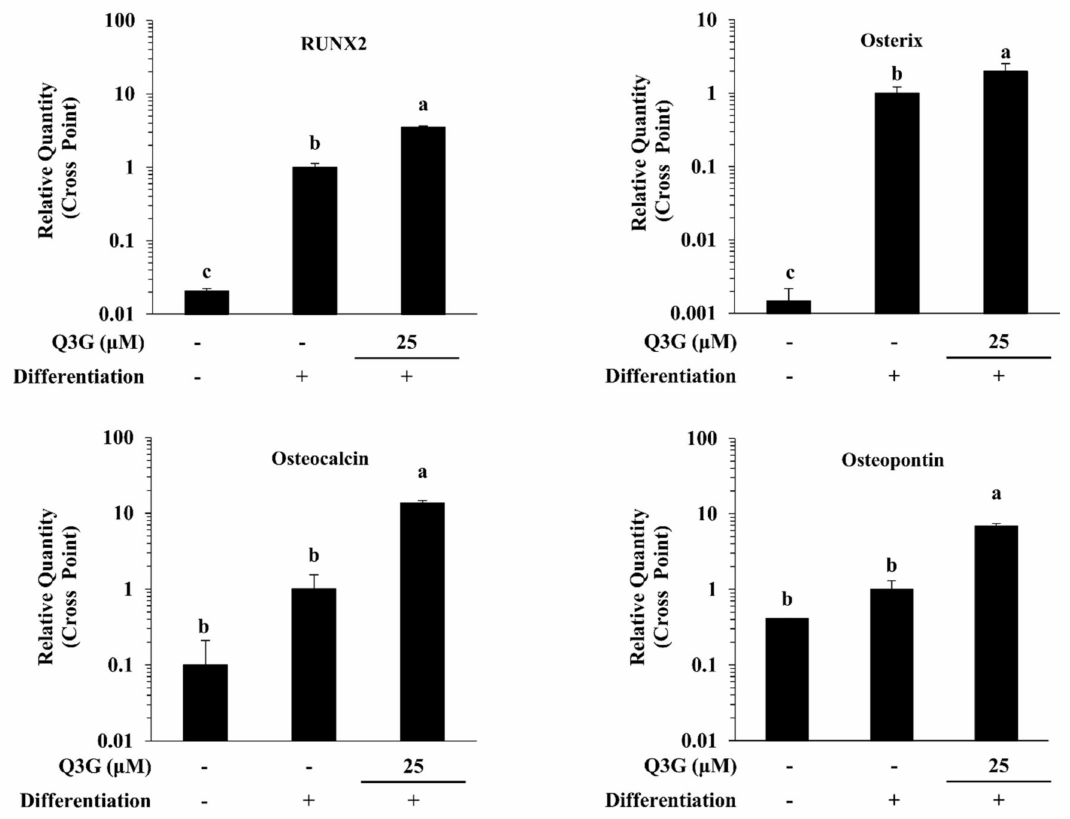
Figure 3. E ff ect of Q3G on osteoblastogenesis marker gene expression. Analysis of gene expression was carried by measuring mRNA levels of osteo-induced hBM-MSCs via RT-qPCR at day 10 di ff erentiation. Values are normalized against β -actin as internal loading control. Osteo-induced hBM-MSCs were treated with Q3G until day 3 of di ff erentiation. Di ff erent letters (a–c) indicate statistically significant di ff erence ( p <